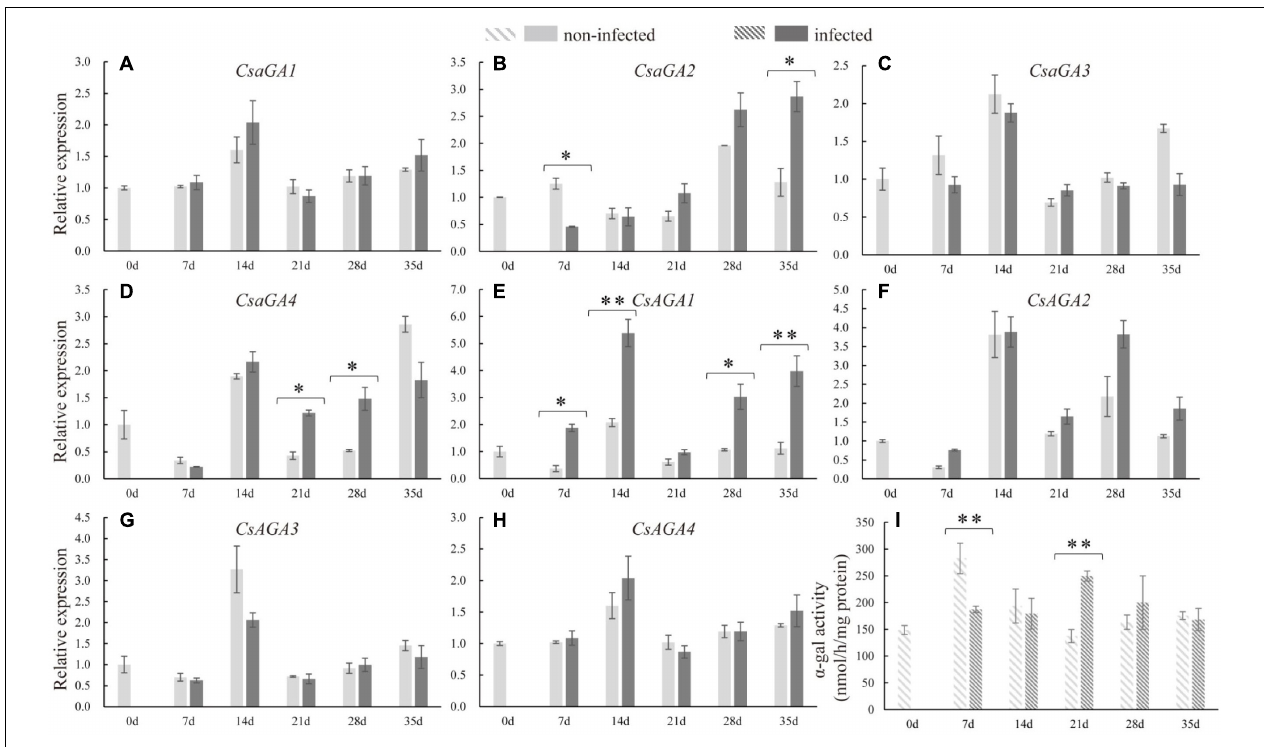
FIGURE 4 | Expression levels of α -galactosidase genes and α -galactosidase activity analysis in infected and non-infected cucumber roots by M. incognita. (A–D) Are acid α -galactosidase genes, CsaGA1 (A) , CsaGA2 (B) , CsaGA3 (C) and CsaGA4 (D) . (E–H) Are alkline α -galactosidase genes, CsAGA1 (E) , CsAGA2 (F) , CsAGA3 (G) and CsAGA4 (H) . (I) Is α -galactosidase activity analysis. Error bars represent ± SE ( n = 5). Student’s t -test is analyzed between infected and non-infected roots, ∗ P < 0.05; ∗∗ P < 0.01.